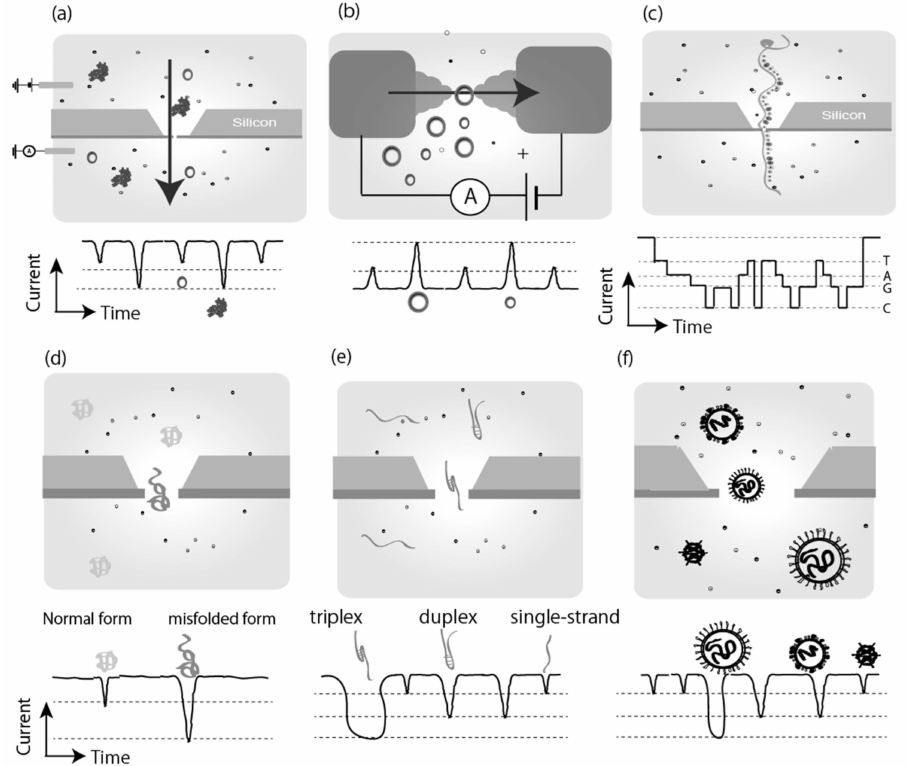
Figure 2. Direct sensing of target molecule/particle by using nanodevices. In single molecule/particle measurement using nanodevices, an electrical signal for a single molecule is observed as a current- time profile when the molecule passes through the sensor device. In the case of nanopore devices, the intensity of decrement in ion current during passage represents the volume of the molecule ( a ), and in the case of nanogap devices, the signal intensity of the tunnel-current represents the electronic conductivity of the molecule ( b ). When a single biopolymer passes through the sensor, each unit of the polymer (nucleotide for DNA and RNA, amino acid for peptide and protein) passes through the sensor, and the electrical signal reflects the sequence of the biopolymer ( c ). Detection of different molecular signals occurs even for the same target molecule. If a structural change has occurred, different electrical signals reflecting the different structures would be observed ( d – f ). In fact, signals reflecting differences in the intramolecular hydrogen bond morphology of proteins (d:prion) and nucleic acid base chains (DNA single-strand, duplex, and triplex) have been observed. In addition, differences of shapes in the nanoparticles and viruses have also been identified by electrical signals reflecting the shape of the particles ( f